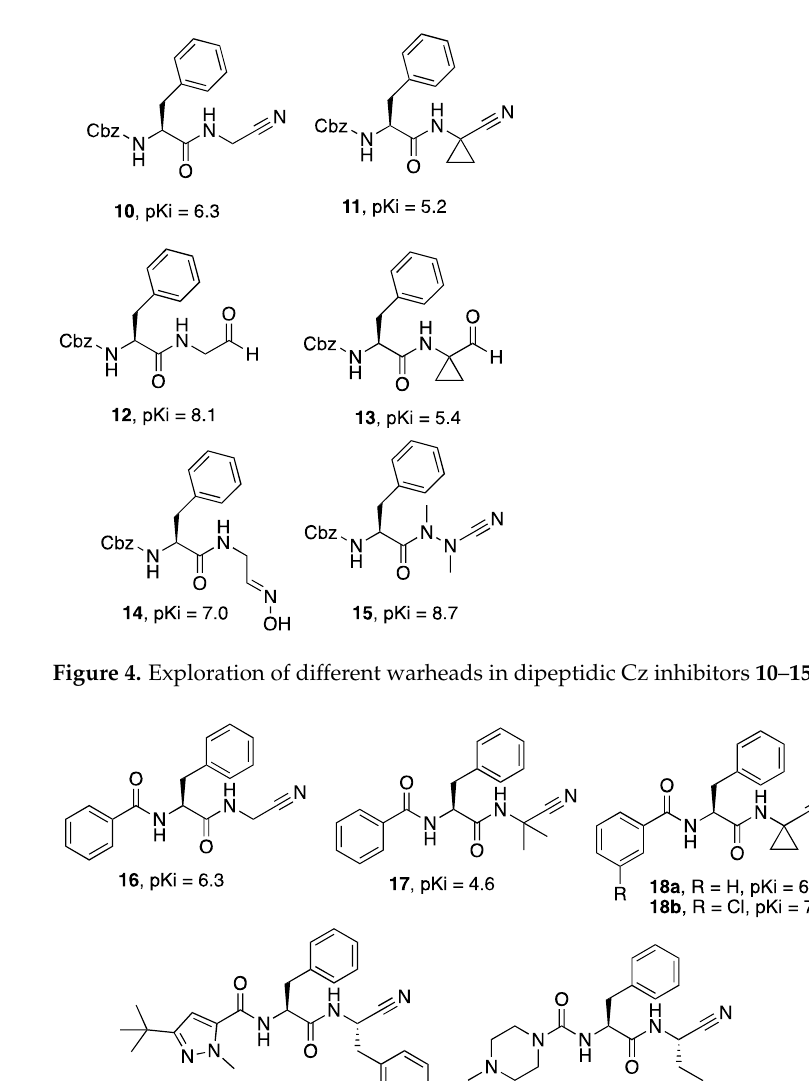
Figure 5. P2/P3-optimized dipeptidic inhibitors ( 16 – 20 ) of Cz.